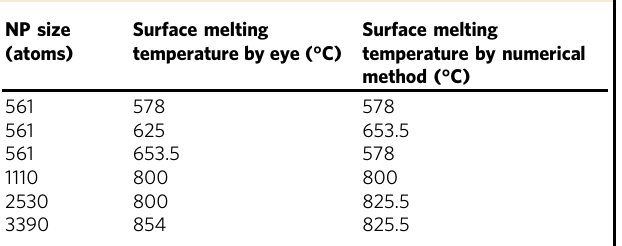
Table 1 A comparison between the surface melting temperatures obtained by the two methods NP size